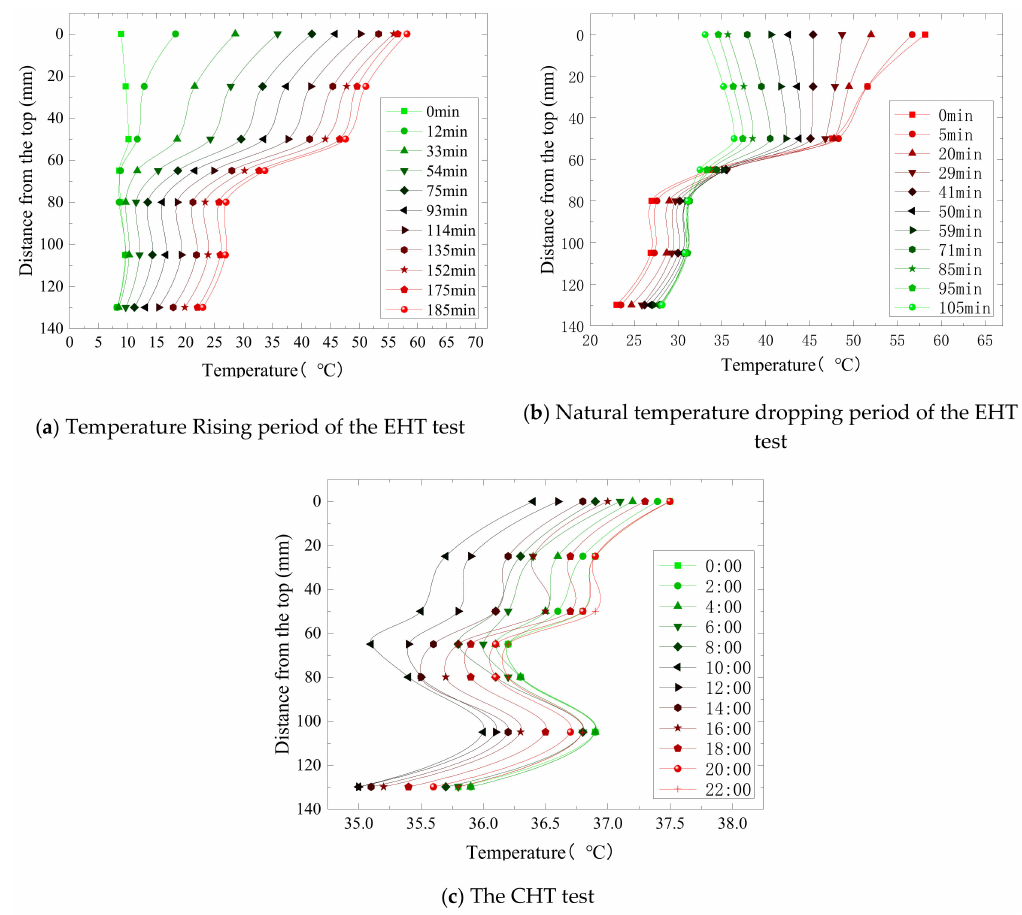
Figure 5. Vertical temperature distribution curves of the track.